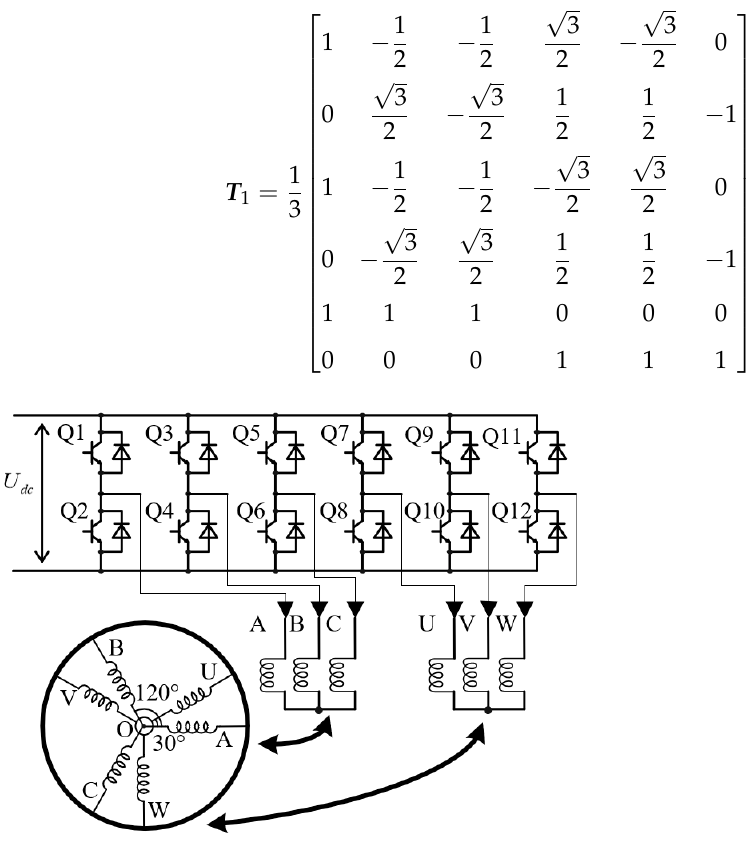
Figure 1. Dual three-phase permanent magnet synchronous motor and its drive circuit. The components in the α − β subspace participate in electromechanical energy con- version. The components in the x − y subspace do not participate in the electromechanical energy conversion and cause energy loss. The components in the o 1 − o 2 subspace are zero-sequence components. Since the neutral points of the two sets of three-phase windings in this study are not connected, the zero-sequence components do not exist. Thus, only the α − β subspace and the x − y subspace can be analyzed. The voltage equation after the above coordinate transformation is expressed as